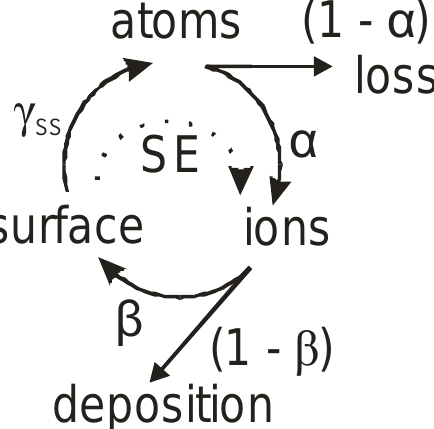
Figure 4 . Schematic presentation of the self-sputtering process in high power impulse magnetron sputtering (HIPIMS), with loss terms and interactions with secondary electrons